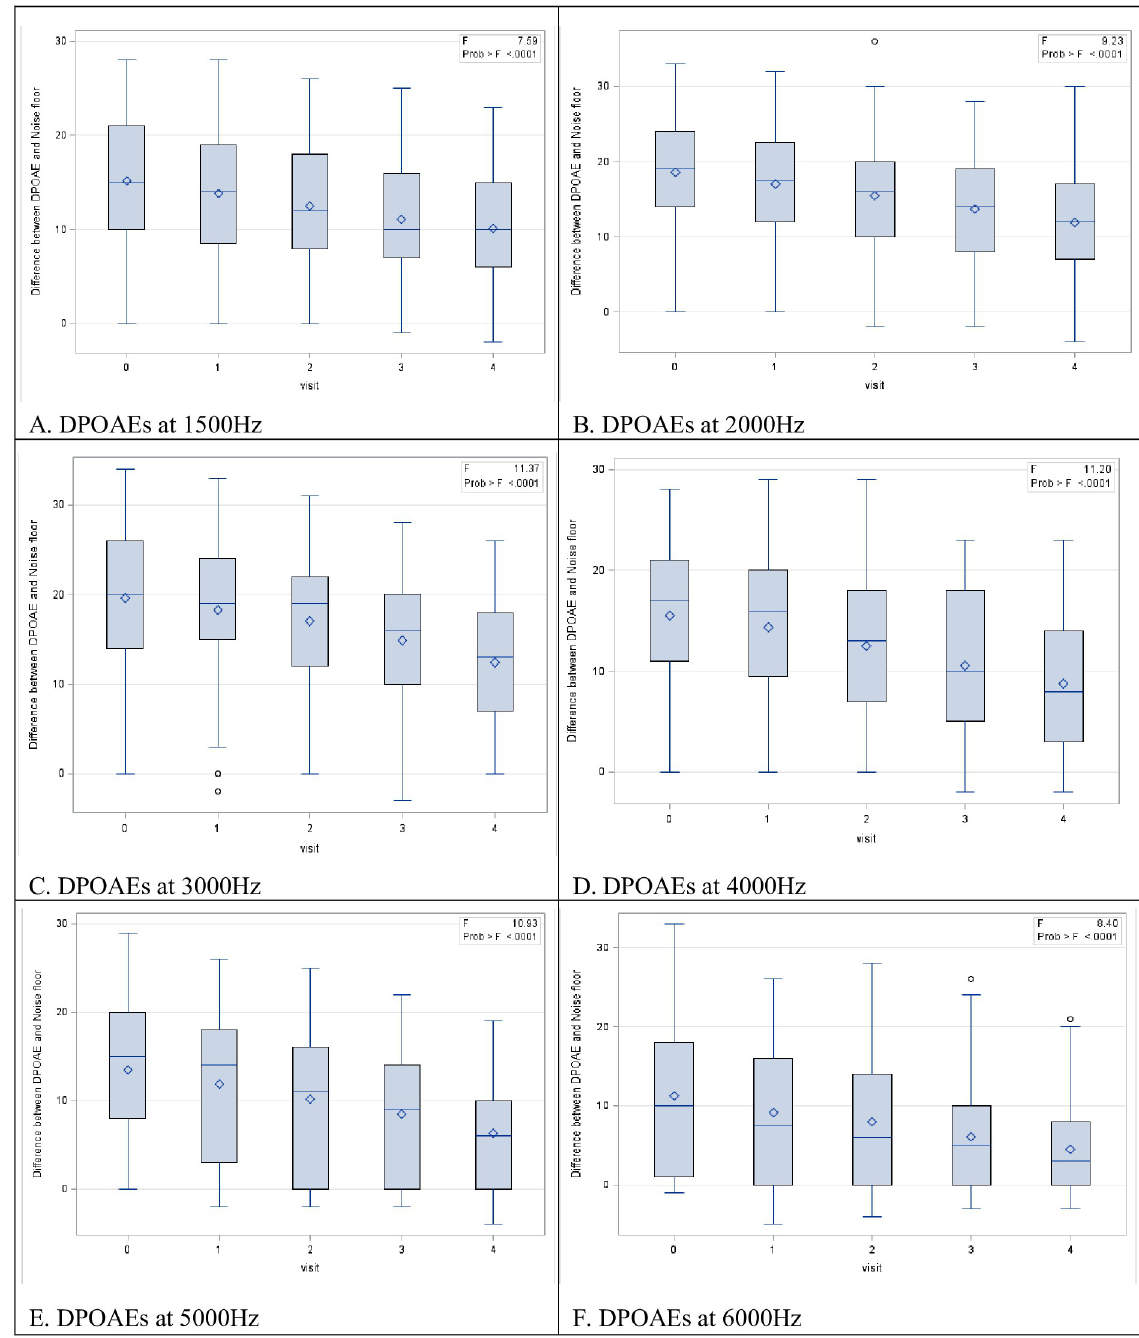
Fig 3. Box plots reflecting the change in the difference between the DPOAE and the noise floor at all frequencies in the left ear. Footnote: ANOVA test revealed a significant decrease (p < 0.05) in the difference between the noise floor and DPOAE at subsequent audiological